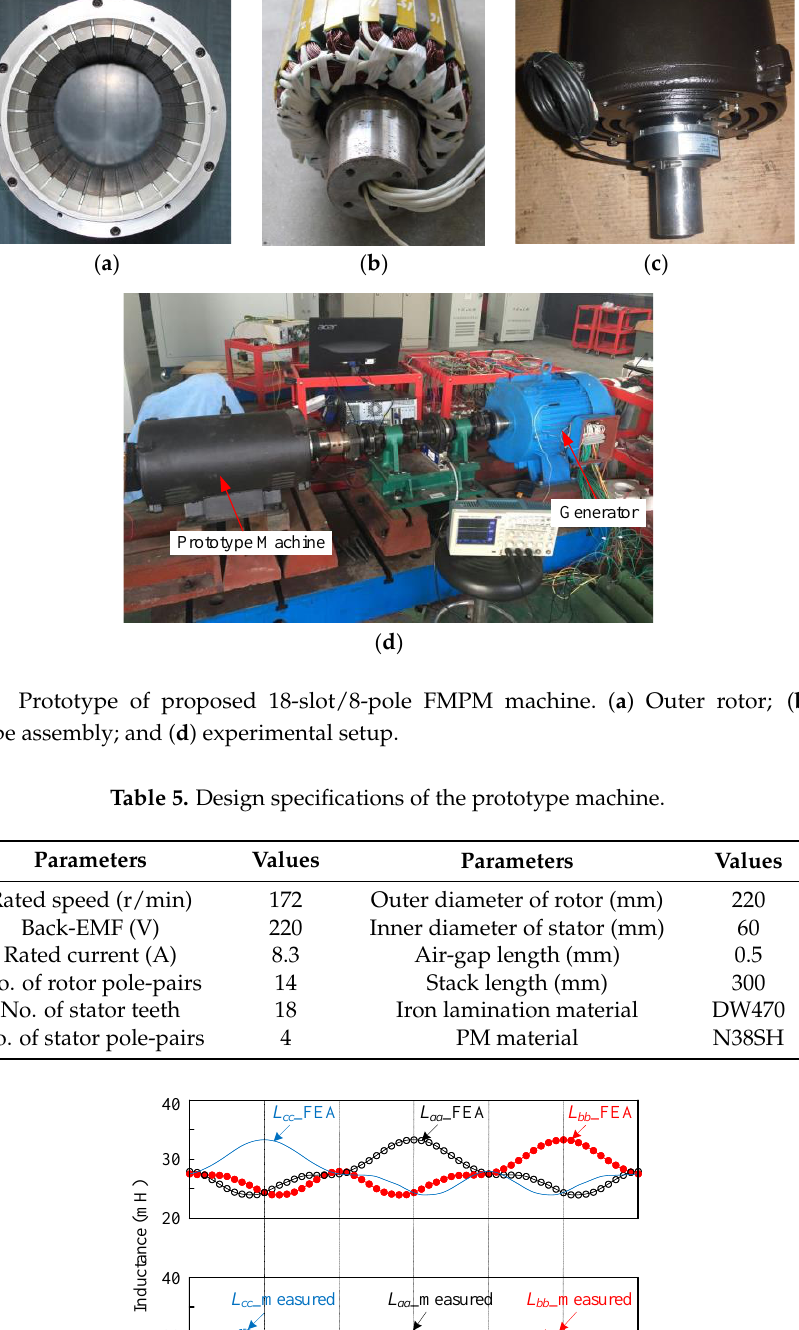
11 of 15 Figure 9. Electromagnetic torque waveforms. Table 4. Characteristics of electromagnetic torque. Items